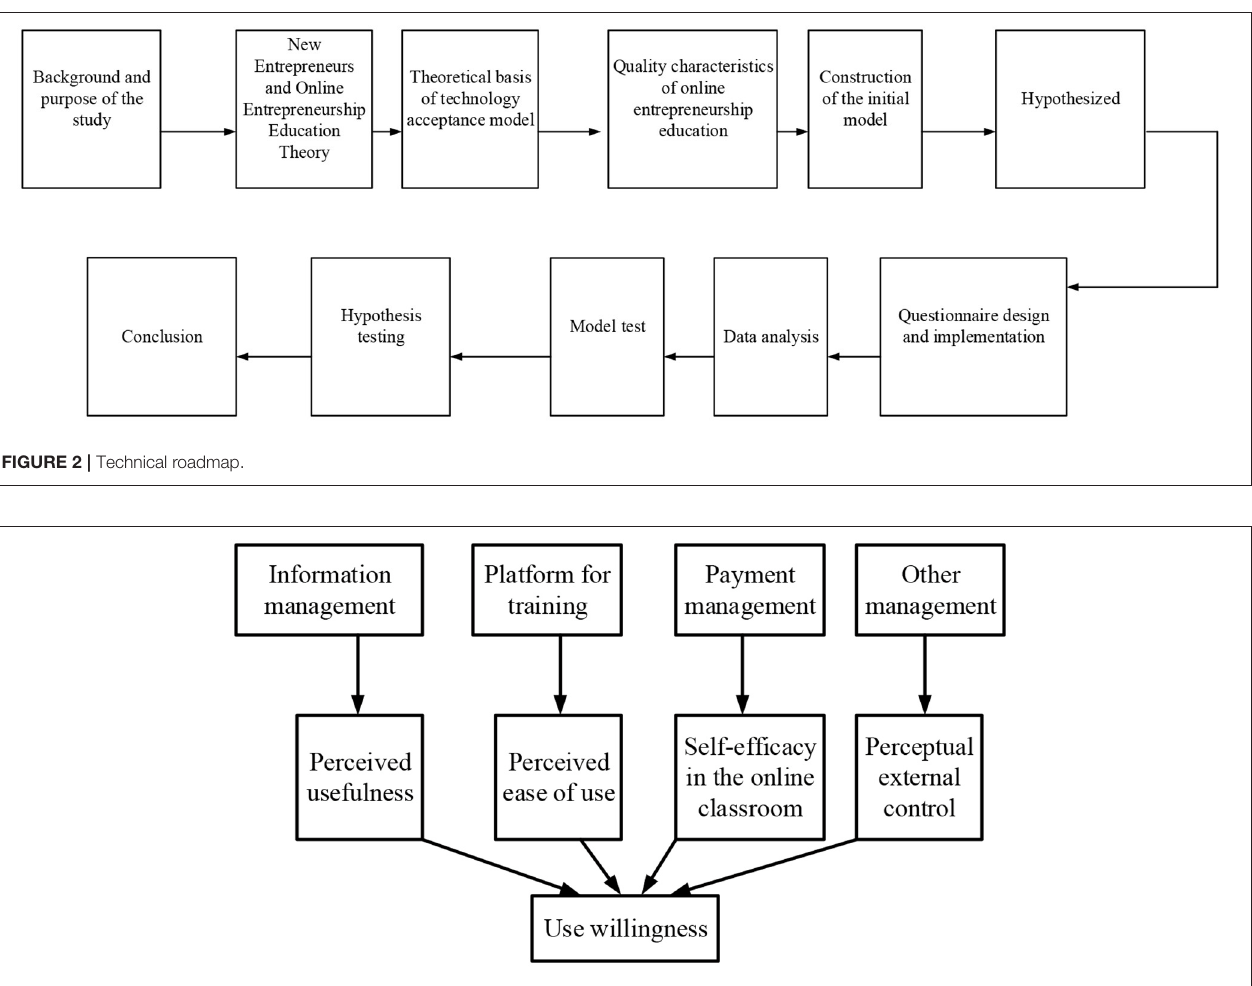
FIGURE 3 | Research model of the intention of